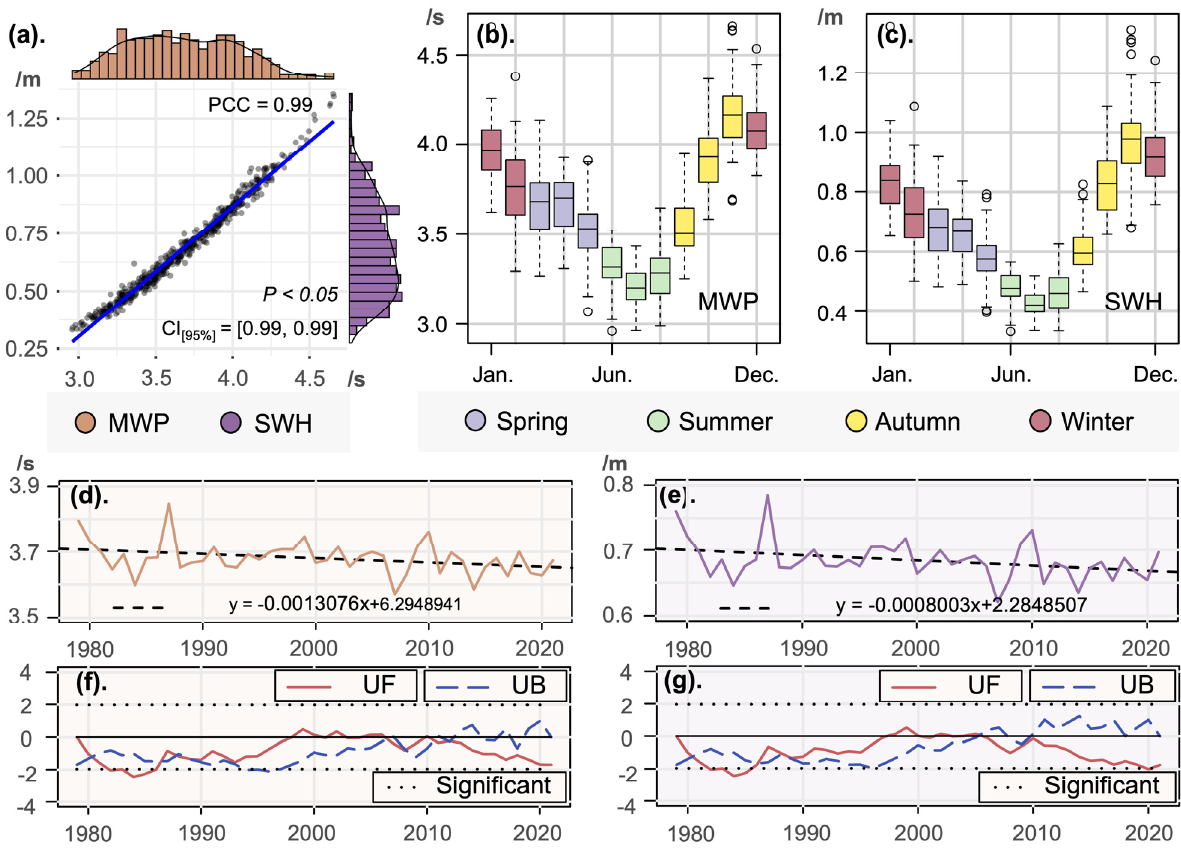
Figure 4. Correlation analysis ( a ), seasonal trend analysis ( b , c ), linear regression ( d , e ), and Mann– Kendall trend testing ( f , g ) for the MWP and SWH.